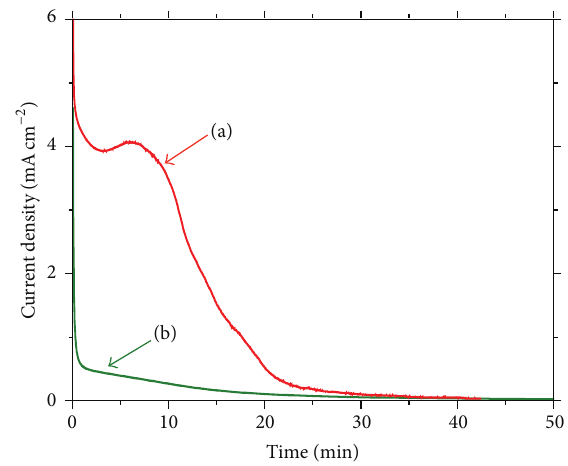
Figure 3: Current-time curves of the natural graphite powder (NG- 7) observed in response to the potential step from 2.9 to 0.3 V in (a) 2.8 and (b) 3.8 mol dm −3 LiClO 4 dissolved in PC.